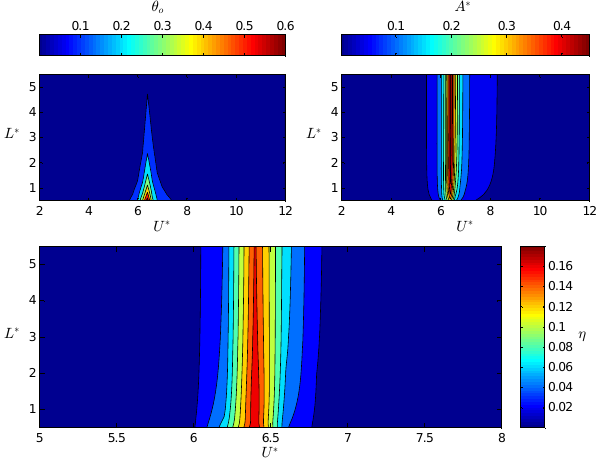
Figure 5. Contours of θ o and η as functions of L ∗ and U ∗ for m ∗ = 50 and ζ = 0.01.